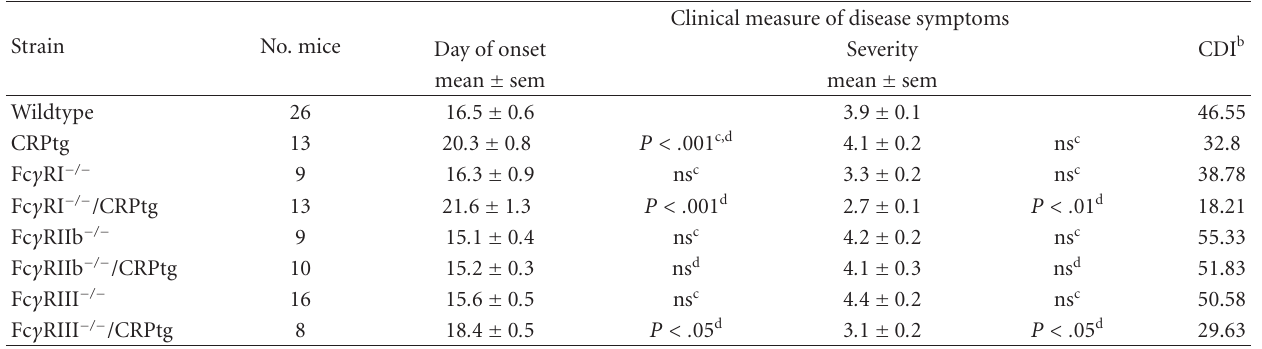
Table 1: E ff ect of transgenic expression of human CRP on the outcome of EAE in mice lacking various Fc γ receptors a . Strain No.